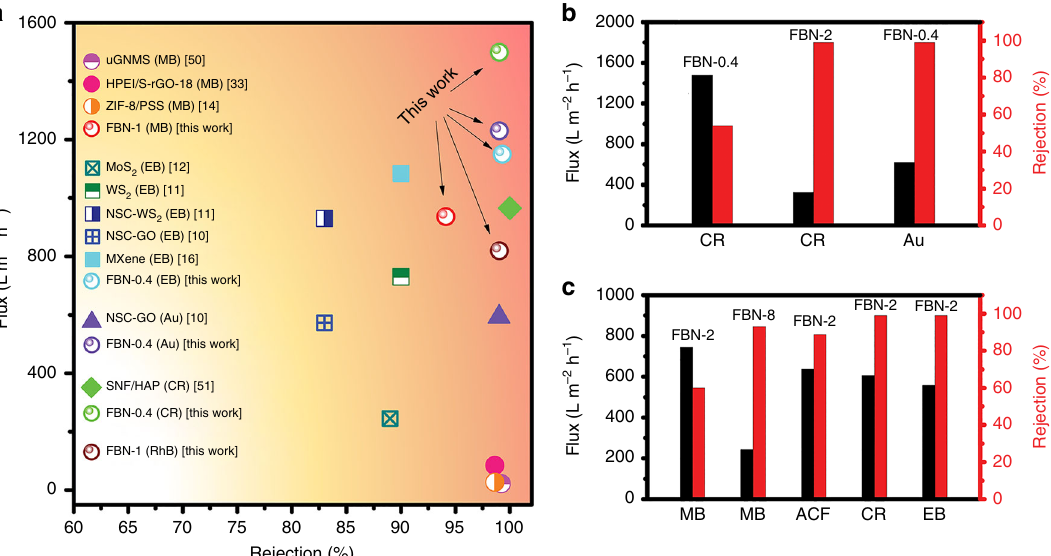
Fig. 5 Separation performance of the functionalized boron nitride membranes. a Comparison of the separation performance of the FBN membranes versus other reported membranes in aqueous media 9 – 12,16,33,53,54 . b Separation performance of FBN for CR (2.5 nm × 0.7 nm, concentration of 50 mg/L) and Au nanoparticles (5 nm) in ethanol solution. c Separation performance of FBN membrane versus molecular size in methanol solution (MB: 1.4 nm × 0.6 nm, concentration of 1.5 mg/L; ACF: 1.2 nm × 1.1 nm, concentration of 3 mg/L; CR: 2.5 nm × 0.7 nm, concentration of 13 mg/L; EB:1.2 nm × 3.1 nm, concentration of 7 mg/L). For details, see the supporting information (Supplementary Tables 1 – 5) 33,55 – 57 . The fl ux values refer to the solvent fi ltration rate from